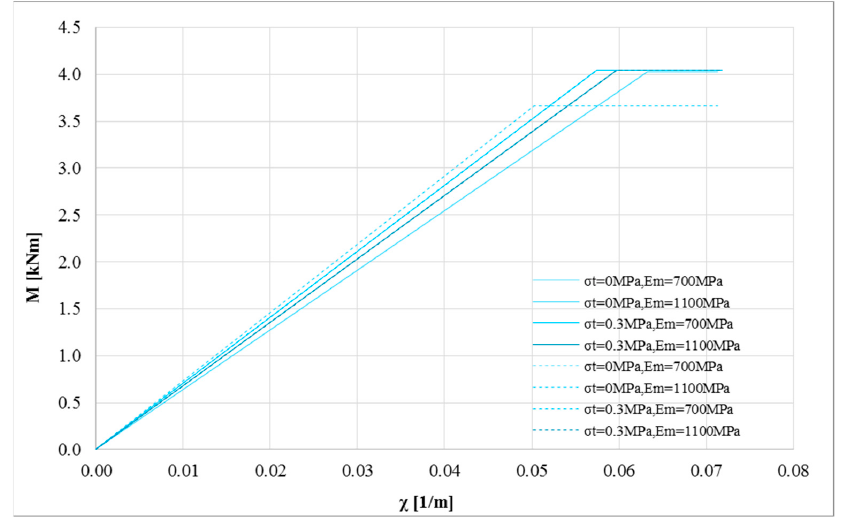
Figure 12 . Bi-linearized M- χ curves: P = 0 N, σ 0 = 1 MPa, σ t = 0 and 0.3 MPa, E m = 700 and 1100 MPa for tri-linear (solid lines) and bi-linear (dotted lines) relationships for the strengthening system (hemp fiber).